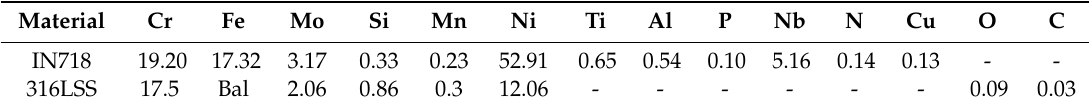
Table 1. Compositions of the IN718 and 316L Stainless Steel (wt. %).